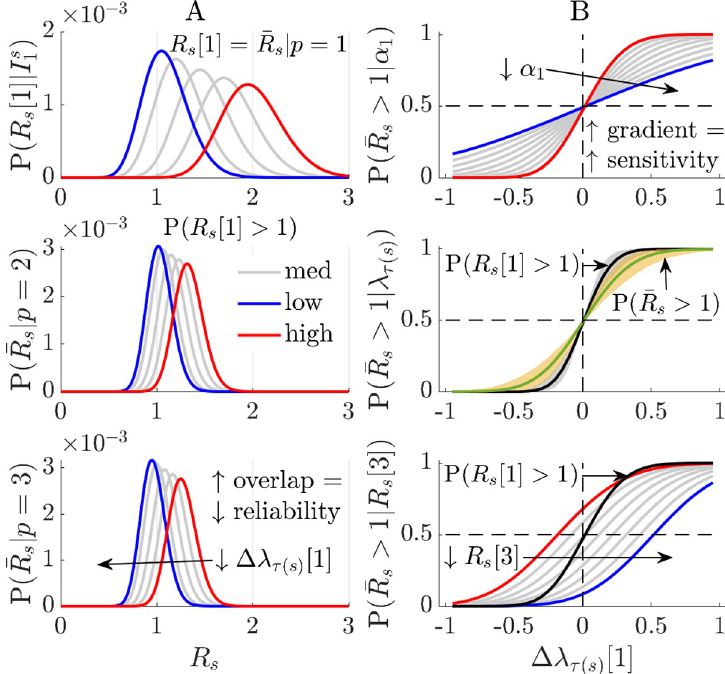
Fig 4. Influence of heterogeneities in transmission. We investigate how differences in transmissibility among groups (e.g., due to demographic or spatial factors) fundamentally limit the ability to detect resurgence from a specific group (in this example group 1 with reproduction number R [1]). Panel A shows that the grouped posterior distribution s becomes less sensitive to a fixed relative change in group 1 incidence, D l 1 ½ � ¼ i t ð s Þ ½ 1 �(cid:0) l t ð s Þ ½ 1 � (the level of change t ð s Þ l t ð s Þ ½ 1 � (the overall reproduction number across groups) are more increases from blue to red). Posterior distributions over � R s overlapped (and tighter in variance) as p rises, for fixed R [1] (top). Panel B plots how overall resurgence detection s probability P ð � R > 1 Þ depends on the weight ( α 1 , top, 0.05–1) and epidemic size ( λ [1], middle, 20–80, p = 2) as well τ ( s ) s as changes in R s [3] (bottom, 0.5–1.2, p = 3). Decreases in α 1 (red to blue) or λ τ ( s ) [1] mean other groups mask the resurging dynamics in group 1, reducing sensitivity (curves become less steep). In the latter case the P ð � R > 1 Þ (green s with solid line at median of λ τ ( s ) [1] range) is always more conservative than P( R s [1] > 1) (black with solid median line). As R [3] falls (red to blue) the ability to detect resurgence also lags relative to that from observing group 1 (black). s